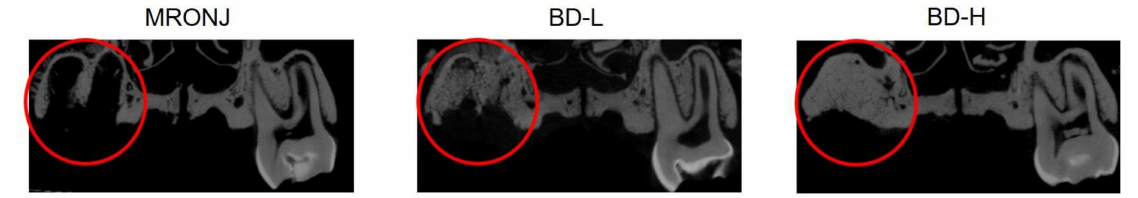
Figure 2. µ CT findings in the center of the extraction sockets. More new bone formation is observed in the BD-administered group than the MRONJ group.